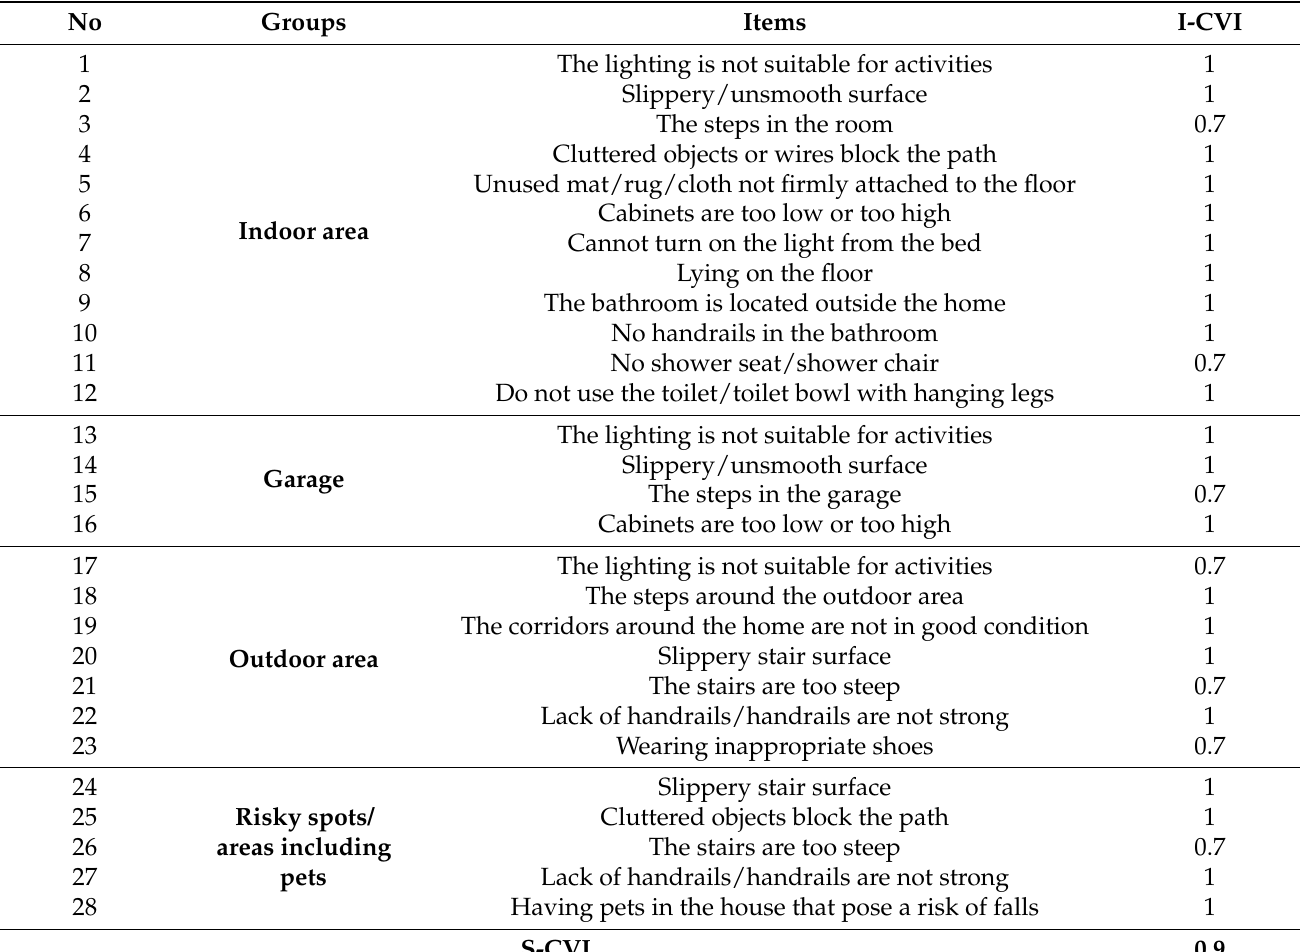
Table 3. The value of the item content validity index (I-CVI) and the content validity for the scale